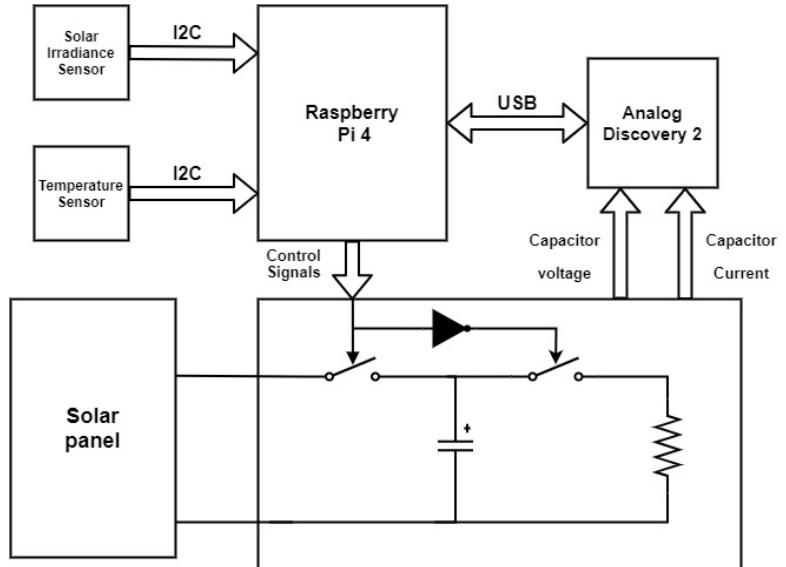
Figure 7. I–V curve tracer block